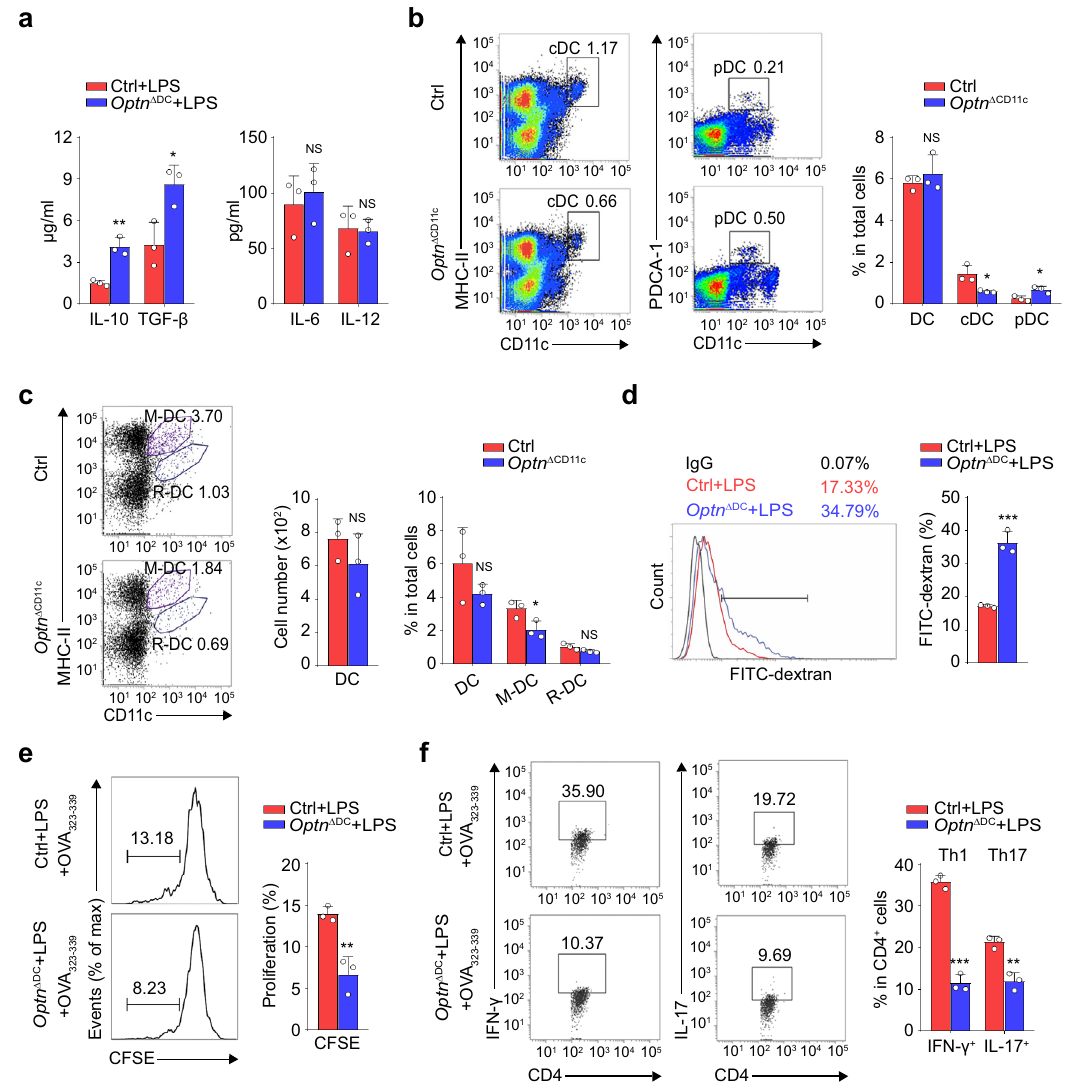
Fig. 2 OPTN regulates the T cells priming function of DC. a ELISA of cytokines in supernatants of LPS treated Ctrl and Optn null BMDCs. n = 3 independent experiments, P (IL-10) = 0.0029, P (TGF- β ) = 0.0239, P (IL-6) = 0.6114, P (IL-12) = 0.8559. b Flow cytometry analysis of the frequency of total DC (CD11c + ), conventional DC (cDC, CD11c + MHCII + ) and plasmacytoid DCs (pDC, CD11c + PDCA-1 + ) in the spleen of Ctrl and Optn Δ CD11c mice. n = 3 independent animals, P (DC) = 0.4925, P (cDC) = 0.0271, P (pDC) = 0.0216. c Flow cytometry analysis of the frequency of total DC (CD11c + ), migratory (M- DC, MHCII hi CD11c + ) and resident (R-DC, MHCII int CD11c + ) DCs in the draining lymph nodes of Ctrl and Optn Δ CD11c mice. n = 3 independent animals, P (DC number) = 0.2950, P (DC%) = 0.2297, P (M-DC) = 0.0394, P (R-DC) = 0.0776. d Uptake of FITC-dextran was measured by fl ow cytometry in Ctrl and Optn null BMDCs. n = 3 independent experiments, P = 0.0007. e Proliferation rate of CFSE-labeled OT-II CD4 + T cells incubated with Ctrl or Optn null BMDCs pulsed with OVA 323-339 . n = 3 independent experiments, P = 0.0055. f The percentages of differentiated Th1 and Th17 subsets of OT-II CD4 + T cells incubated with Ctrl or Optn null BMDCs pulsed with OVA 323-339 . n = 3 independent experiments, P (IFN- γ ) = 8.6E-05, P (IL-17) = 0.0028. Data are presented as means ± SD. * P < 0.05; ** P < 0.01; *** P < 0.001; NS, not signi fi cant. Unpaired two-tailed Student ’ s t -test. Source data are provided in Source data fi